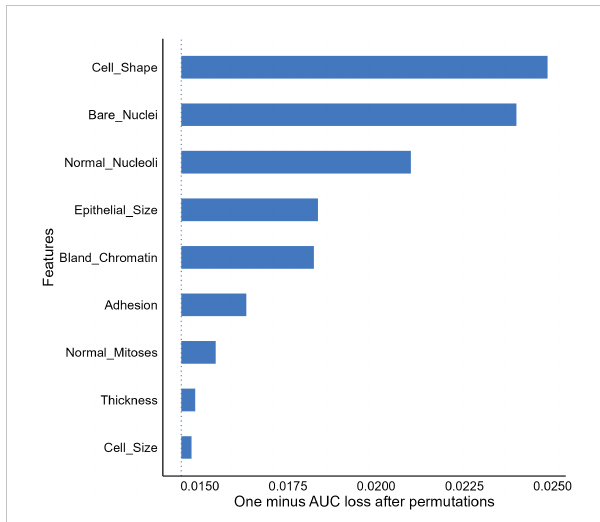
FIGURE 3 Feature importance (FI) analysis for the extreme gradient boosting tree model. AUC, Area under the receiver-operating